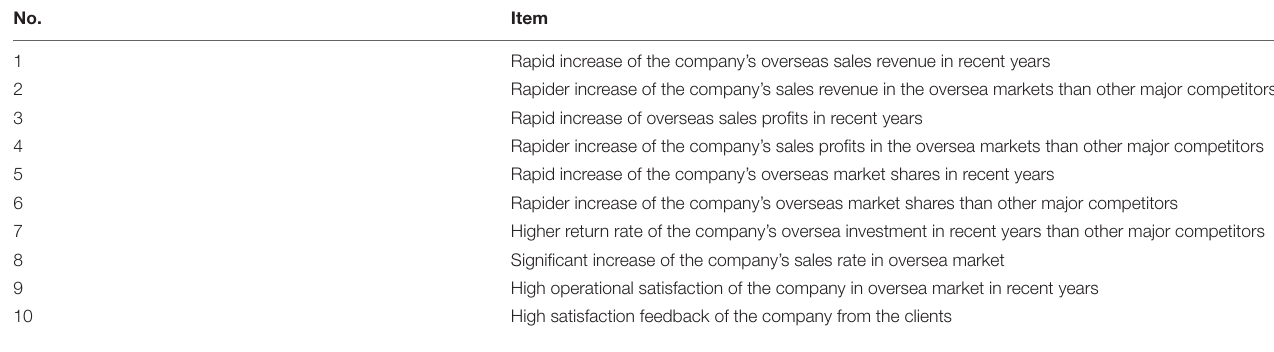
TABLE 3 | Evaluation scale of the international